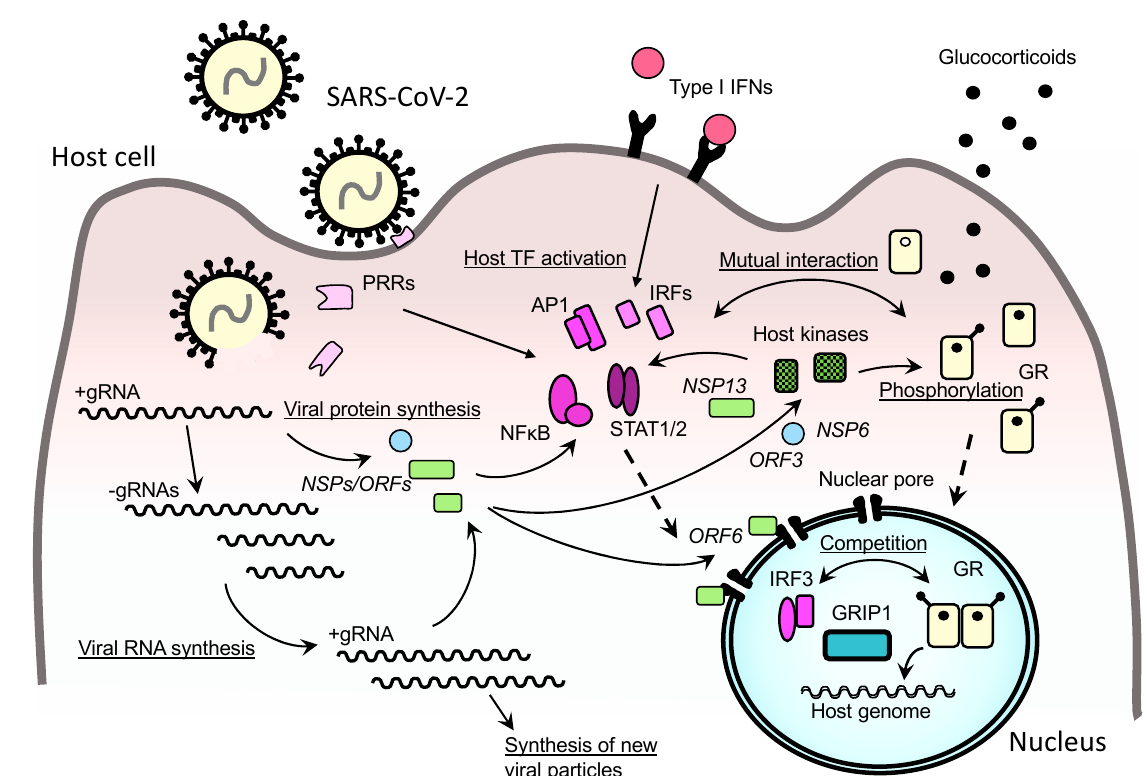
Figure 4. SARS-CoV-2 ′ s life cycle in a host cell and its expected interference with the GR signaling pathway. Upon infection to a host cell, SARS-CoV-2 releases its positive-sense single-stranded genomic (g) RNA into the cytoplasm and initiates synthesis of its RNAs and their encoding proteins. On the other hand, the infection activates local anti-viral innate immune system through host PRRs, which in turn stimulate production/release of type I IFNs. Activated PRRs and released IFNs further stimulate host transcription factors (e.g., NF κ B, AP1, STATs and IRFs) for the expression of ISGs and proinflammatory cytokine genes. Some of the produced viral proteins (e.g., NSP6, NSP13, ORF3, and ORF6) shift host cell activities toward viral replication, such as by changing the activities of host kinases, transcription factors, nuclear pore complex, and RNA processing machinery, whereas they downregulate host innate immunity. In the process of modulating host cell activities, SARS-CoV-2 appears to suppress coincidentally the facilitative effects of GR on viral replication by affecting multiple components of its intracellular signaling pathway. Host and viral proteins are indicated with regular and italic letters, respectively. AP1: activator protein-1, GR: glucocorticoid receptor, GRIP1: glucocorticoid receptor-interacting